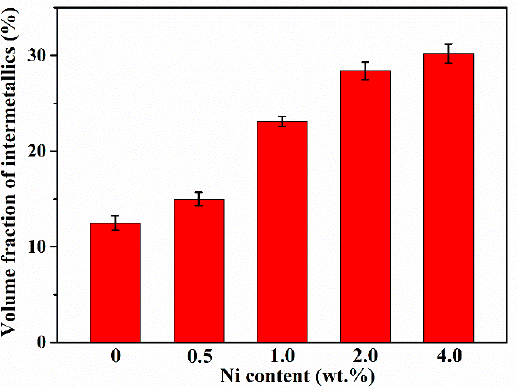
Figure 10. The volume fraction of intermetallics at the grain boundaries and interdendritic regions as a function of Ni content. Table 5. The volume fraction of intermetallic compounds phases at the grain boundaries and inter- dendritic areas in the 0.5 Ni alloy.